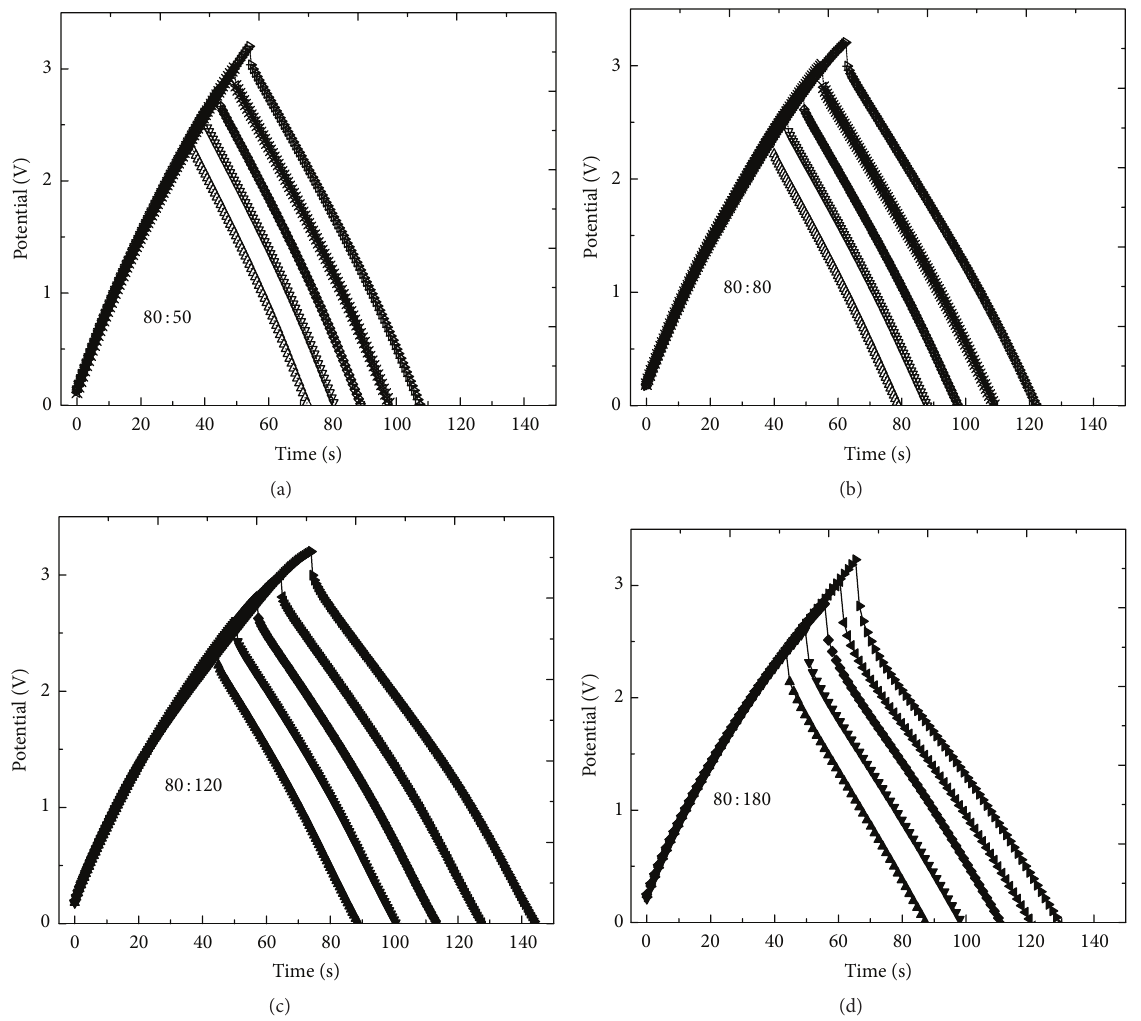
Figure 4: Galvanostatic charge-discharge cures. (a) 𝑟 = 80 :50. (b) 𝑟 = 80 : 80. (c) 𝑟 = 80 : 120. (d) 𝑟 = 80 : 180.